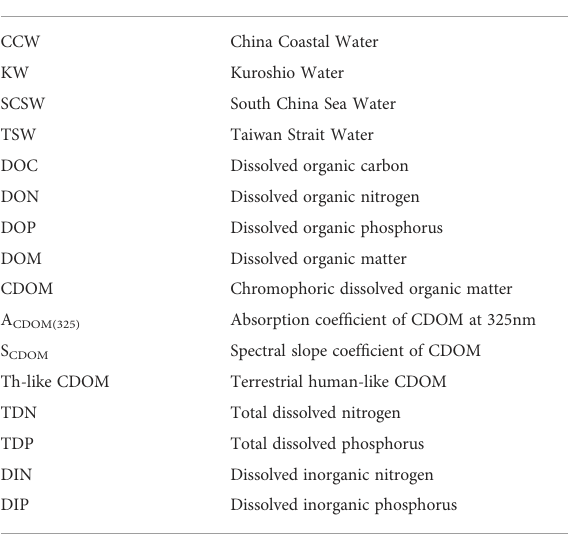
TABLE 1 Acronyms used in this